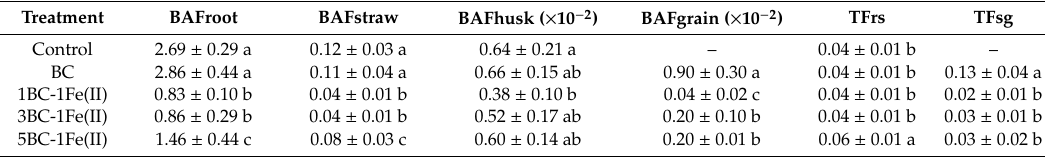
Table 4. Bioaccumulation factors (BF) and translocation factors (TF) of As.